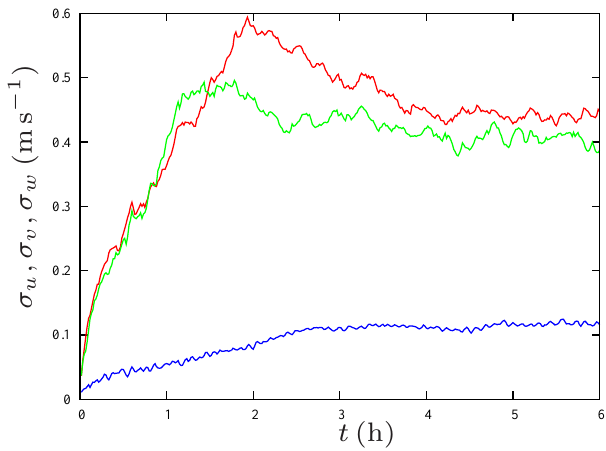
Figure 5. Temporal evolution of velocity fluctuations σ u (red lines), σ v (green lines), and σ w (blue lines) for the moderate forcing case and 1 = 4m (run